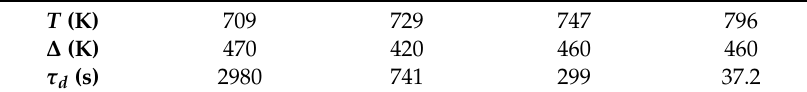
Figure 2. The experimental temporal dependences (points, [9]) of the reduced hydrogen coverages θ ( t ) / θ (0) of the Si(111)7 × 7 adsorbent at di ff erent temperatures and the initial condition θ (0) = 0.08. The solid (red) curves represent the theoretical processing of the data [9] by Equation (12) with parameters ∆ and τ d pointed out in Table 1. The inset demonstrates an Arrhenius plot of the found τ d values by Equation (7) with τ d ∞ = 1.01 × 10 − 14 s and U 0 = 28,400 K. Table 1. The results of the theoretical processing of experimental data [9] on the kinetics of hydrogen desorption from the Si(111)7 × 7 surface at di ff erent temperatures and the initial condition θ (0) = 0.08 (Figure 2). The values of the characteristic parameters τ d and ∆ were found by approximating the data [9] according to Equation (12) with the use of the least squares method.